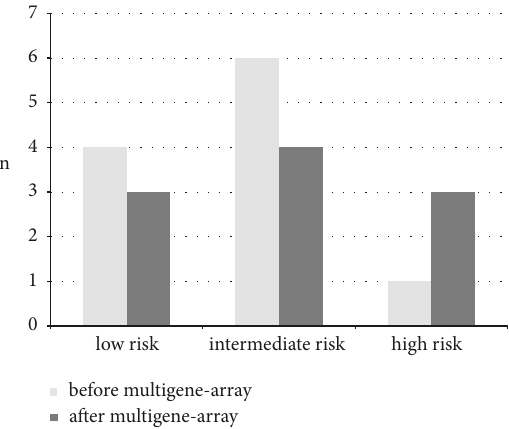
Figure 3: Number of cases with recommendation for adjuvant chemotherapy before and after results of the multigene